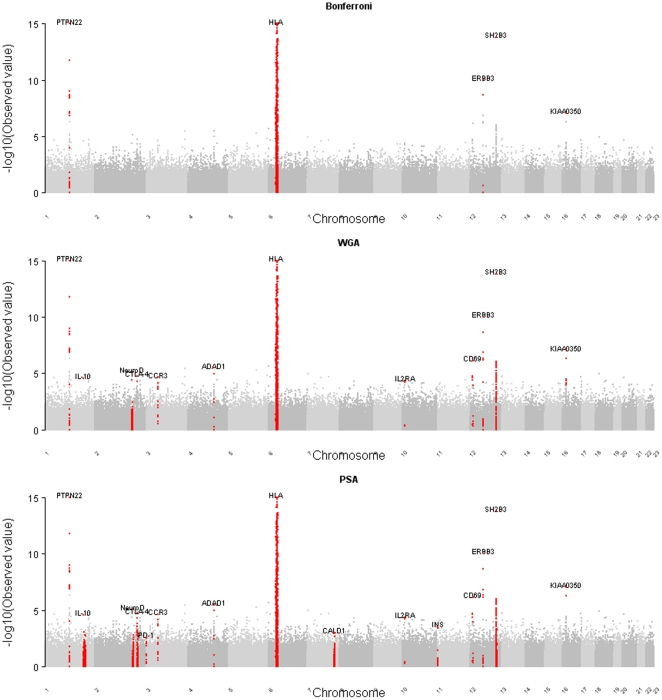
Manhattan plot for the T1D data set.The x-axis lists the chromosome numbers, and the y-axis presents . The red points label the significant genes identified by each method (from top to bottom: the Bonferroni correction to control the FWER at 5%, the WGA to control the FDR at 5%, and the PSA to control the FDR at 5%). This figure was plotted with the R package ‘gap’ [31].